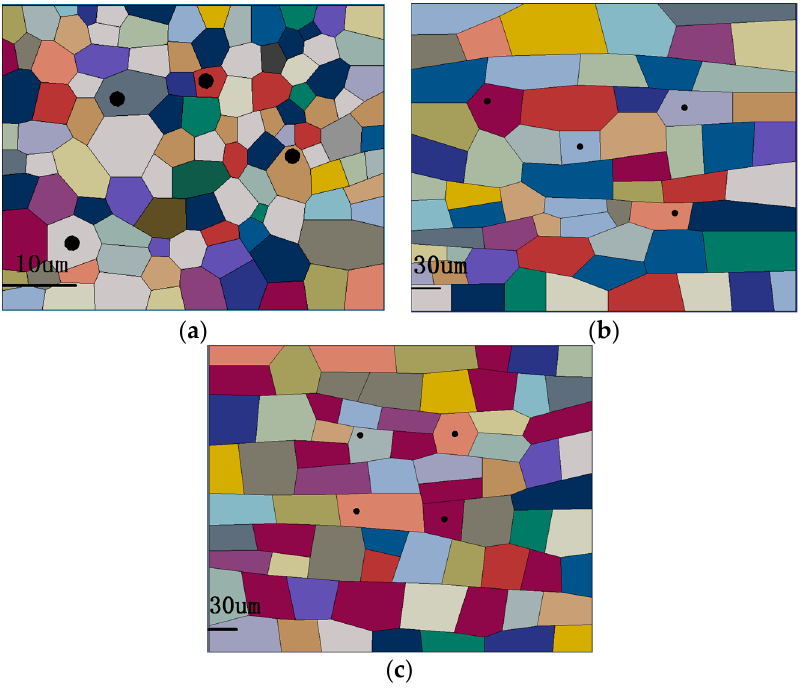
Figure 9. RVEs of ( a ) WNZ, ( b ) TMAZ, and ( c ) HAZ in the joint.